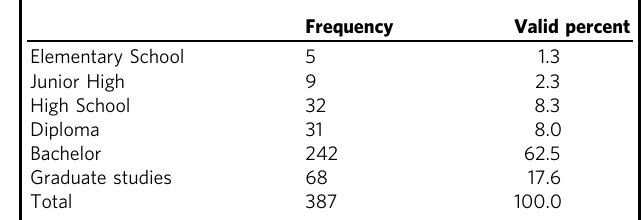
Table 1 Parental education level.